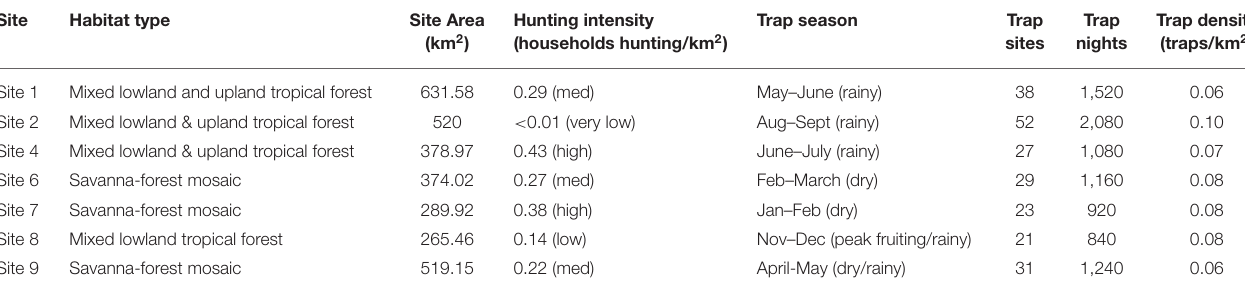
TABLE 1 | Habitat type, area, hunting intensity, season, and camera-trap survey effort at each